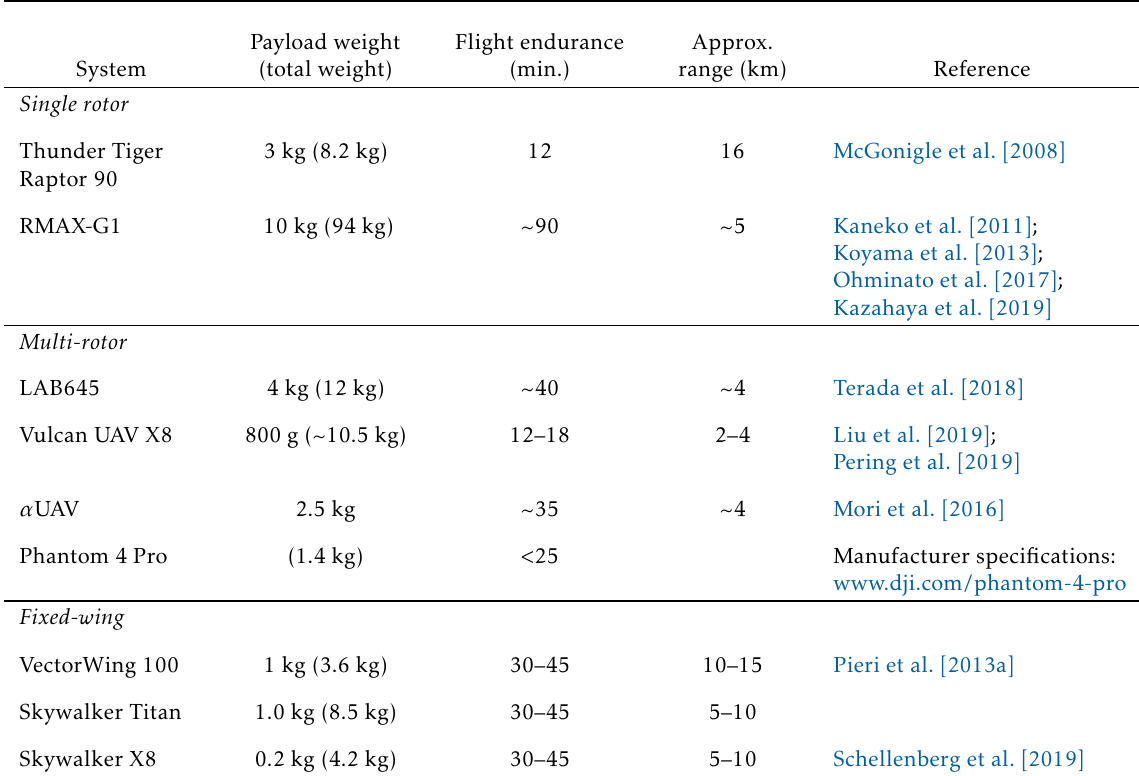
Table 2 – Example vehicle